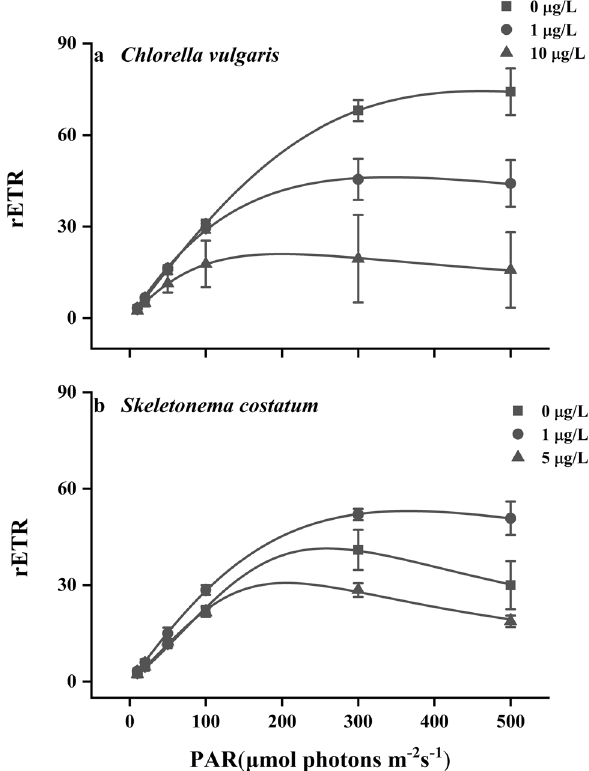
Figure 3. The rapid light curves determined by variations of relative electron transport rate (rETR) under progressively increasing light intensities in Chlorella vulgaris (a) and Skeletonema costatum (b) cells at different phenanthrene concentrations. The data are means ± SD of triplicate cultures (n = 3).